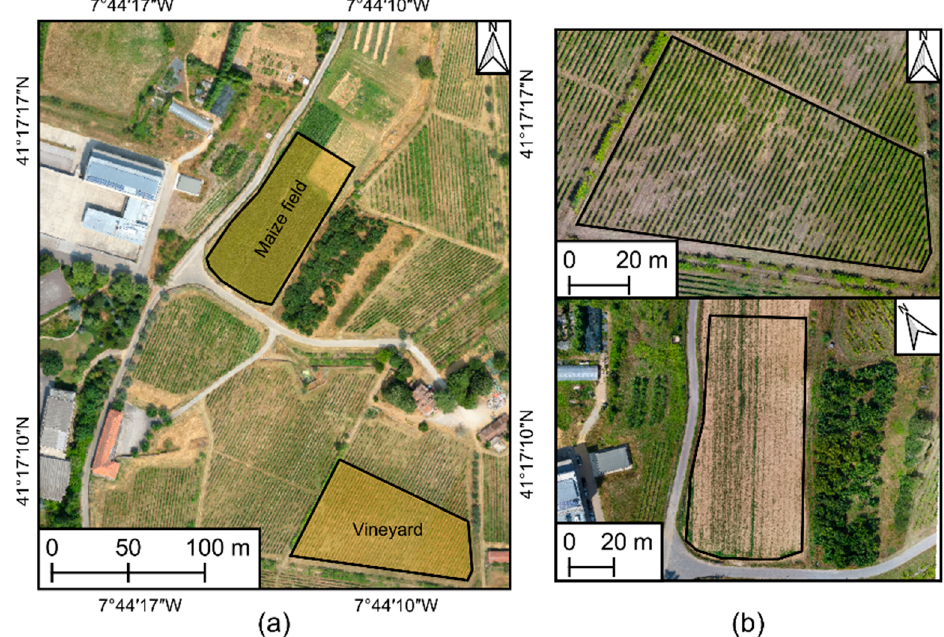
Figure 5. Location of the study areas used for the testing of the developed application ( a ) and its overview ( b ). The orthophoto mosaic used in ( a ) is not representative of the data status used in this study.